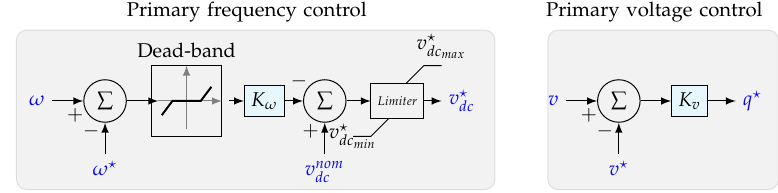
Figure 2. Reference values for the VSC.